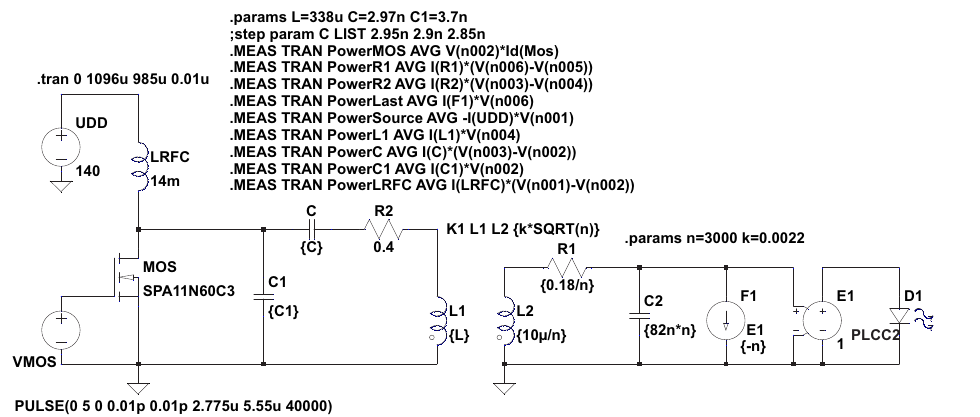
Figure 9. Complete circuit of the 300W amplifier #2 including a load of 3000 WLEs.